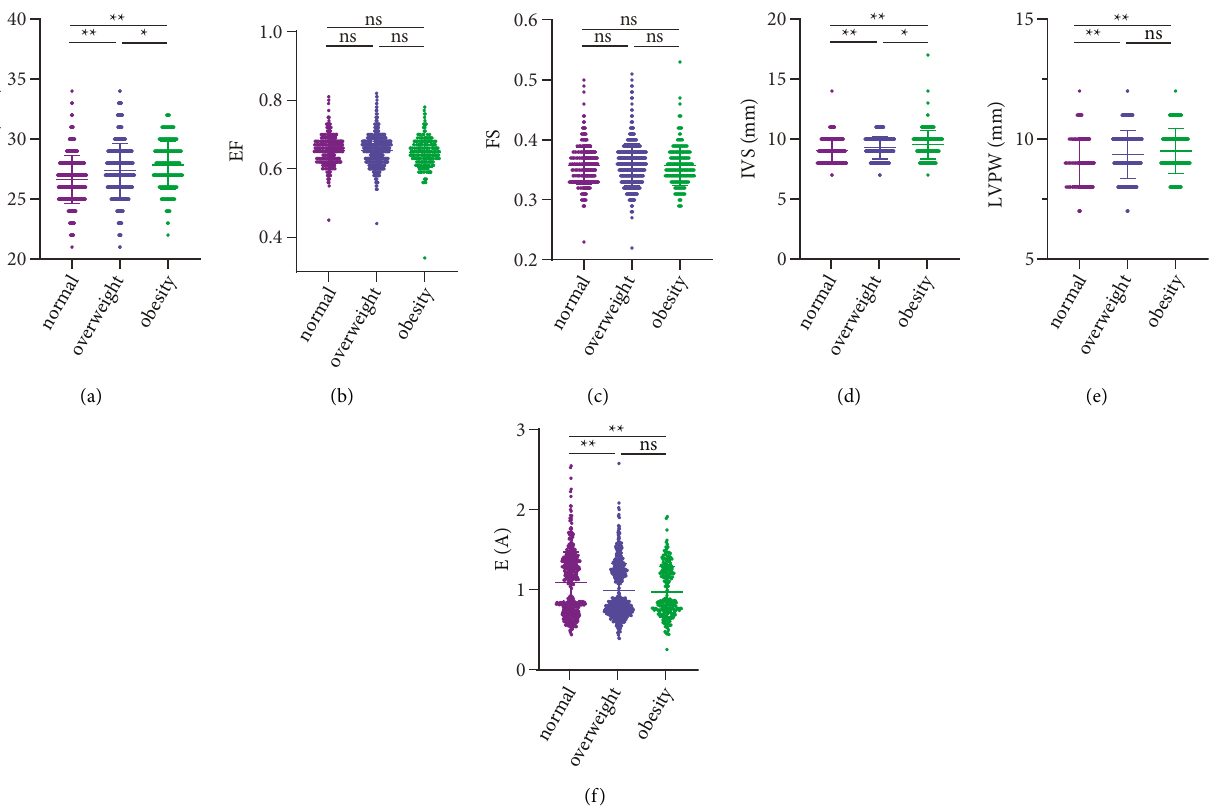
Figure 2: Comparison of cardiac ultrasound indices in normal, overweight, and obese populations. (a) Right ventricular outflow tract (RVOT). (b) Ejection fraction (EF). (c) Fractional shortening (FS). (d) Interventricular septum (IVS). (e) Left ventricular posterior wall (LVPW). (f) E/A Values. ∗∗ P < 0 . 001. ∗ P < 0 . 05 ns P > 0 .